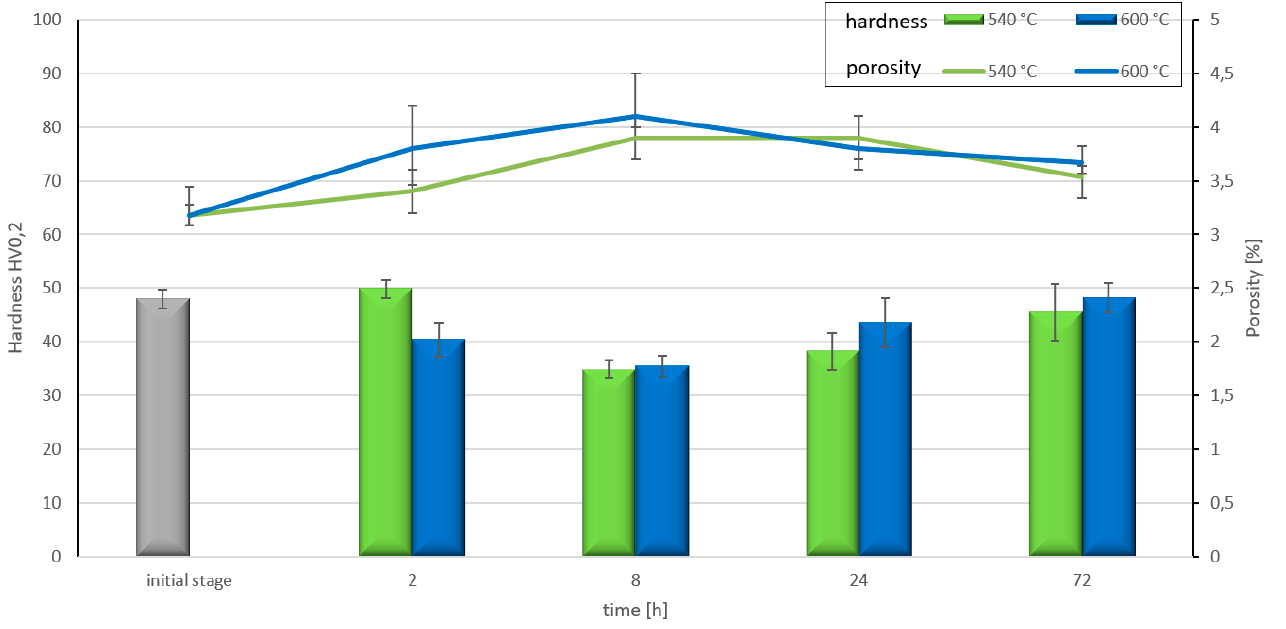
Figure 12. Hardness and porosity of Al-Ti-C composites after heat treatment at different times (2–72 h) and temperatures (540 and 600 °C).